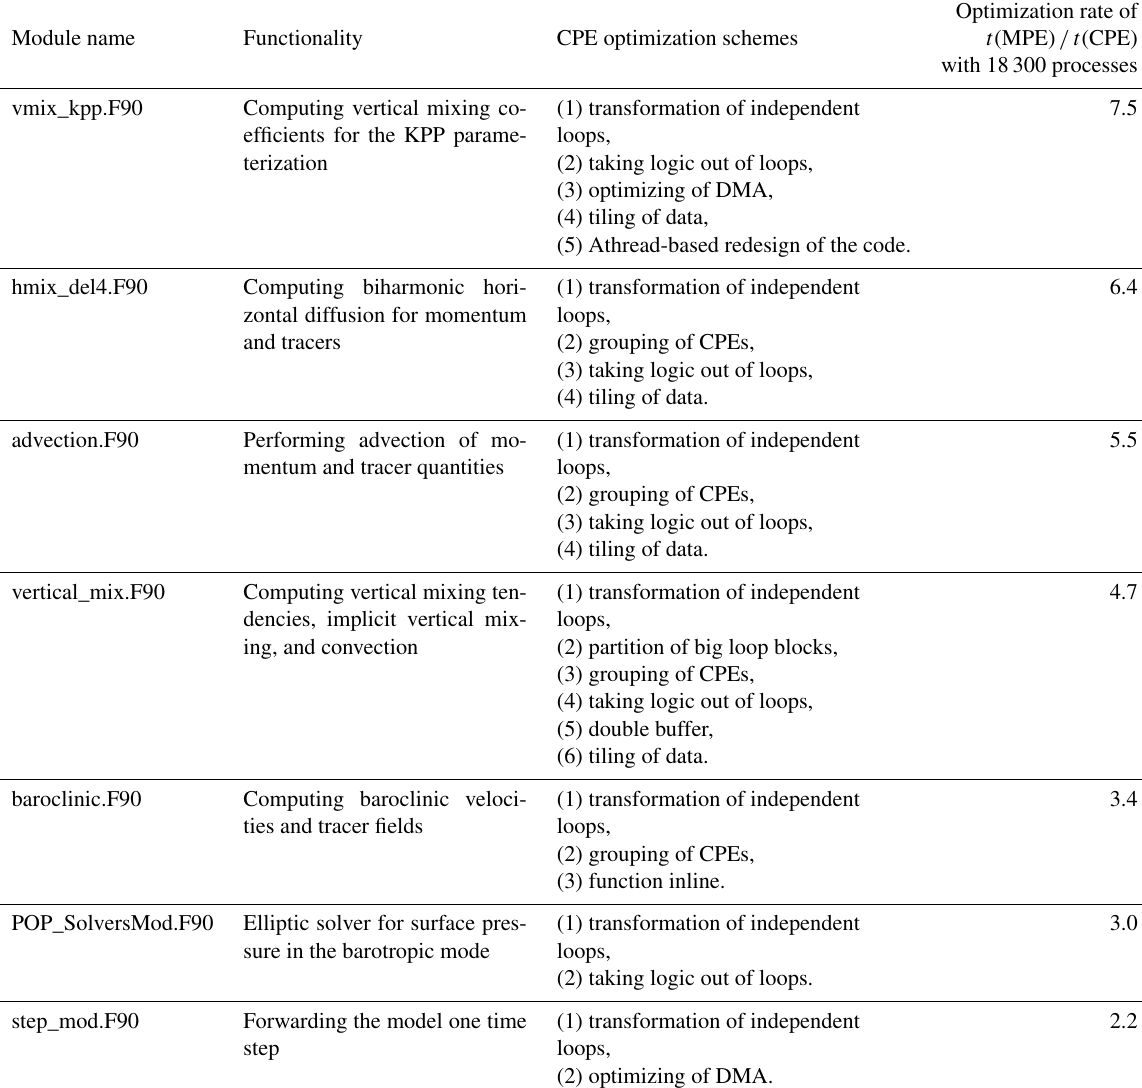
Optimization rate